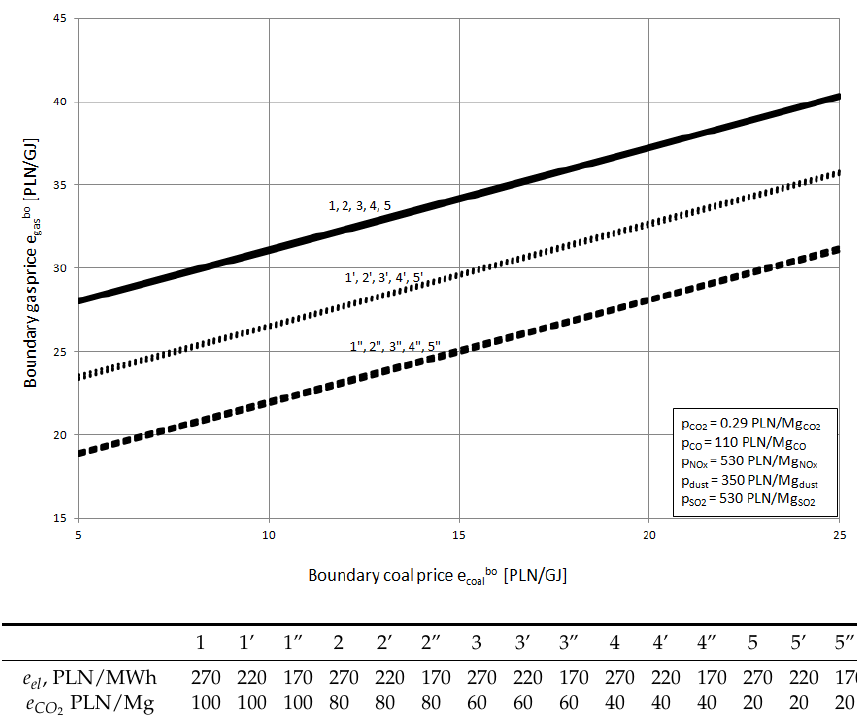
asaparameter. Energies 2018 , 11 , 1784 coal